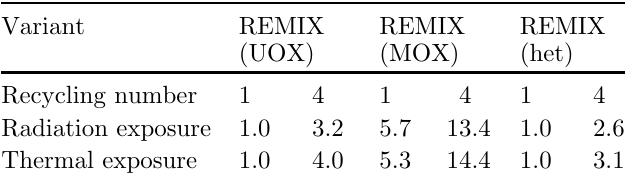
Table 1. Radiation and thermal exposure comparison for fresh fuel in FA.